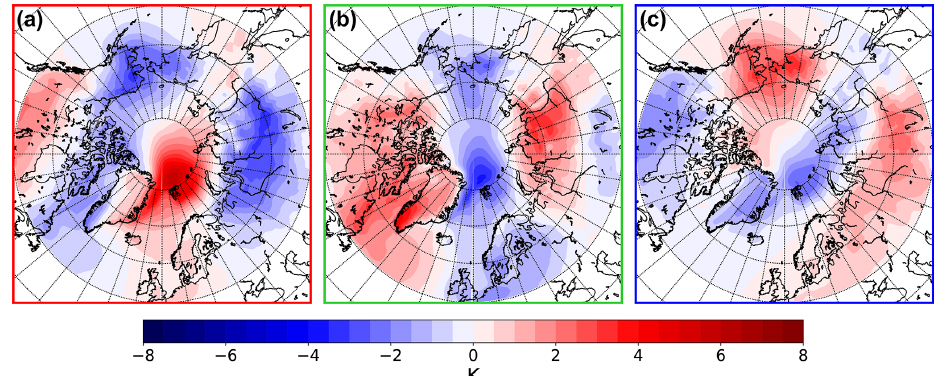
Figure 3. Composite of 2m temperature anomalies for the three pathways: the North Atlantic pathway ( a ; red coloured frame), the Siberian pathway ( b ; green coloured frame), and the North Pacific pathway ( c ; blue coloured frame). Contour spacings show temperature anomalies in 0.5K. Blue colours indicate a cold anomaly and red colours indicate a warm anomaly compared to the mean of the analysed time